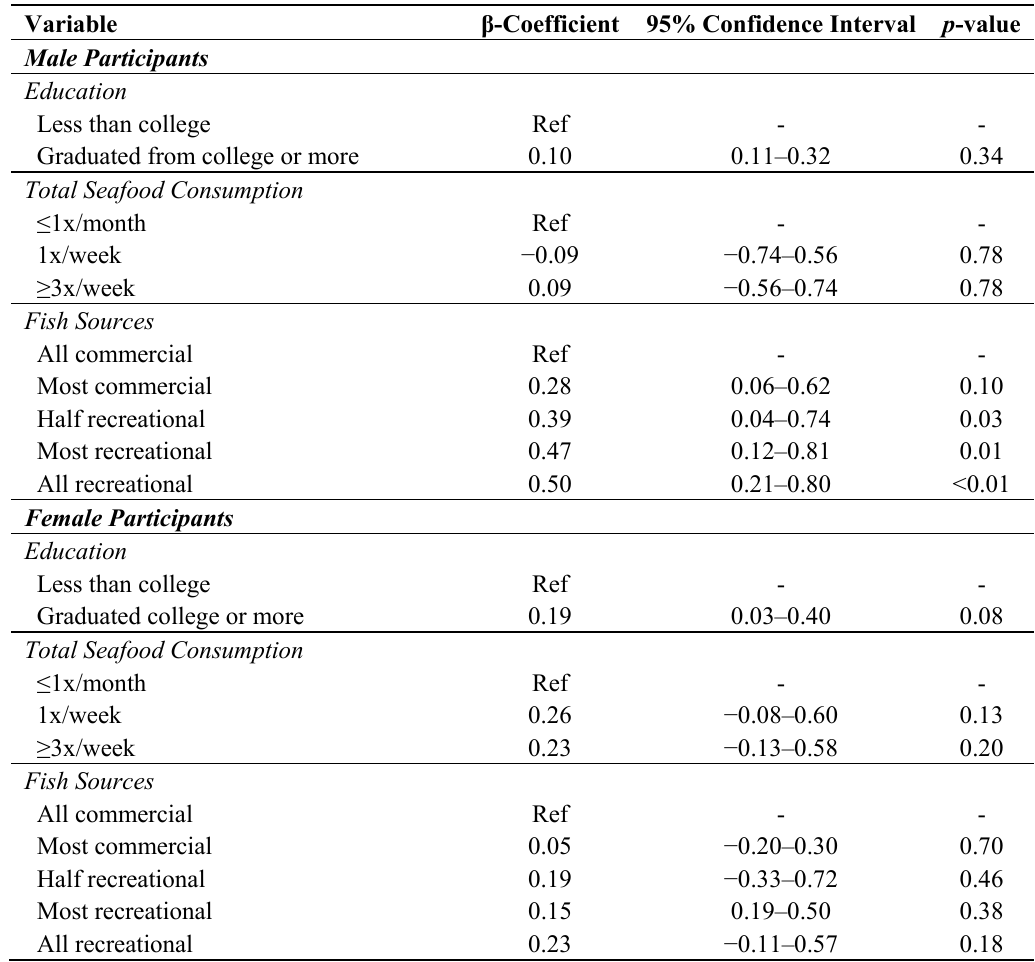
Table 4. Gender stratified multivariable linear regression of demographic variables, fish consumption frequency and sources of fish consumed on log total hair mercury concentration.